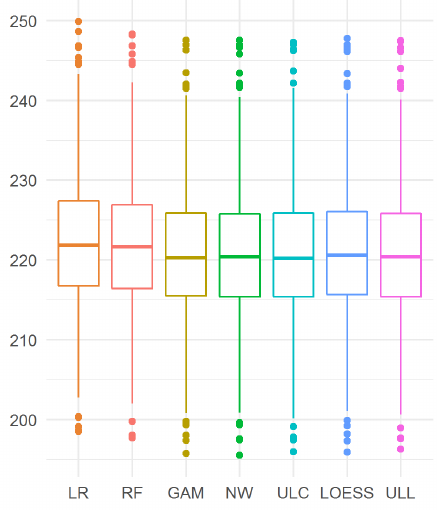
Figure 8. Mean-squared prediction error of the dependence of BP from